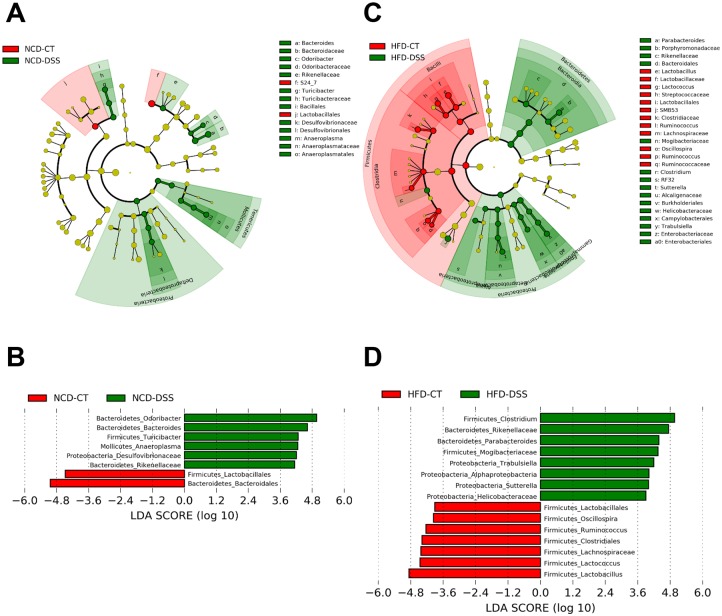
Linear discriminant analysis (LDA) effect size (LEfSe) analysis of gut microbiota changes following consumption of a high-fat diet (HFD) and dextran sodium sulfate (DSS) treatment. Effect of DSS.(A and B) Normal chow diet (NCD)-control (CT) vs. NCD-DSS mice. (C and D) HFD-CT vs. HFD-DSS mice. The phylogenetic tree and histogram show LDA scores calculated for differences in genus-level abundance between DSS-treated and -untreated mice. NCD-CT, NCD-fed mice without DSS treatment; NCD-DSS, NCD-fed mice with DSS treatment; HFD-CT, HFD-fed mice without DSS treatment; HFD-DSS, HFD-fed mice with DSS treatment (n = 5 each). The colors represent the group in which the indicated taxa is more abundant compared to the other group. The LDA scores of the NCD-CT and HFD-CT were negative, while those of the NCD-DSS and HFD-DSS were positive. Such negativity or positivity is determined by alphabetical order of the groups, and the absolute values of the effect size indicate the scale of the difference between 2 groups regardless of the positivity or negativity.